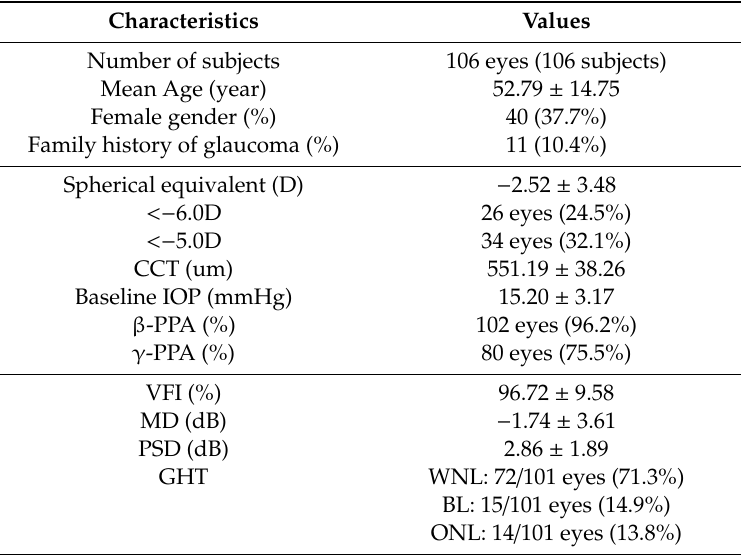
Table 1. Baseline characteristics of included subjects.